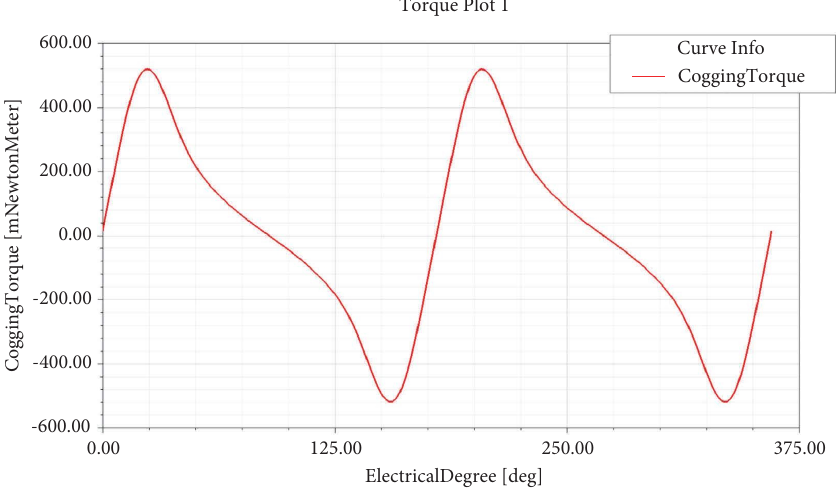
Figure 27: Cogging torque of fat-bottom circular slot motor.